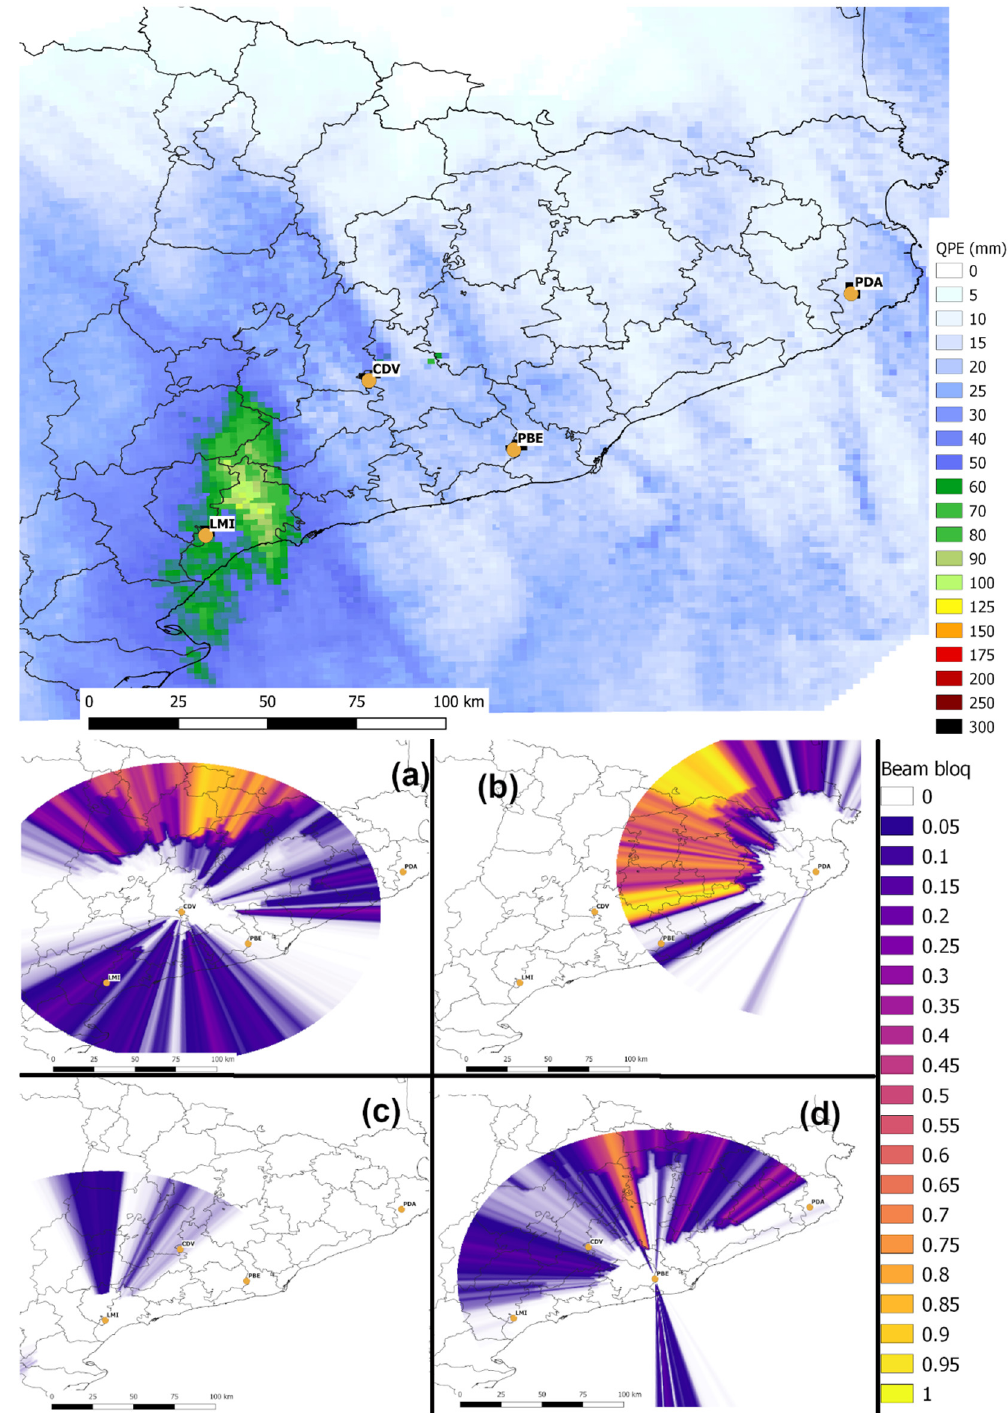
Figure 7. Top : QPE with simple corrections for the 22 October 2019 event. The orange dots indicate the radar positions. Bottom : Beam blockage matrices for all the four radars at the lower elevations (CDV ( a ), PDA ( b ), LMI ( c ), and PBE ( d )).